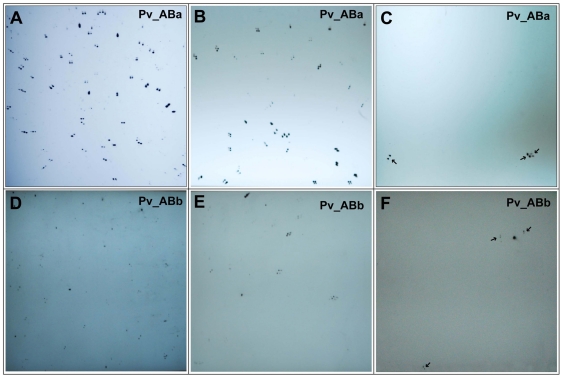
Estimation of organellar DNA contamination and representation of low-copy genes.Switchgrass BAC libraries (Pv_ABa and Pv_ABb) were screened by high-density filter hybridizations to estimate chloroplast- or mitochondrial-specific DNA and representation of single/low copy genes. Representative filter hybridization data used to estimate chloroplast (A, D) and mitochondrial (B, E) contaminants, and the library coverage based on the presence of a single copy gene, brittle culm 10 (C, F). Black arrows in C and F identify the signal from BC10 probes.